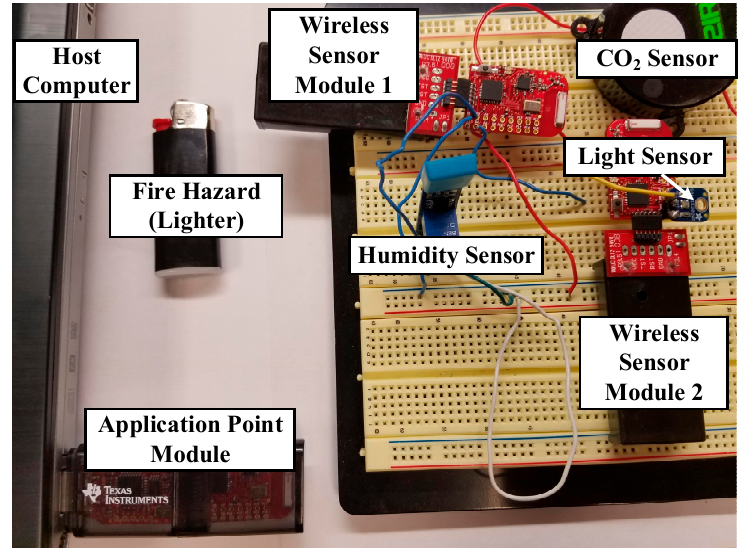
Figure 4. Experimental setup for indoor fire hazard detection system.